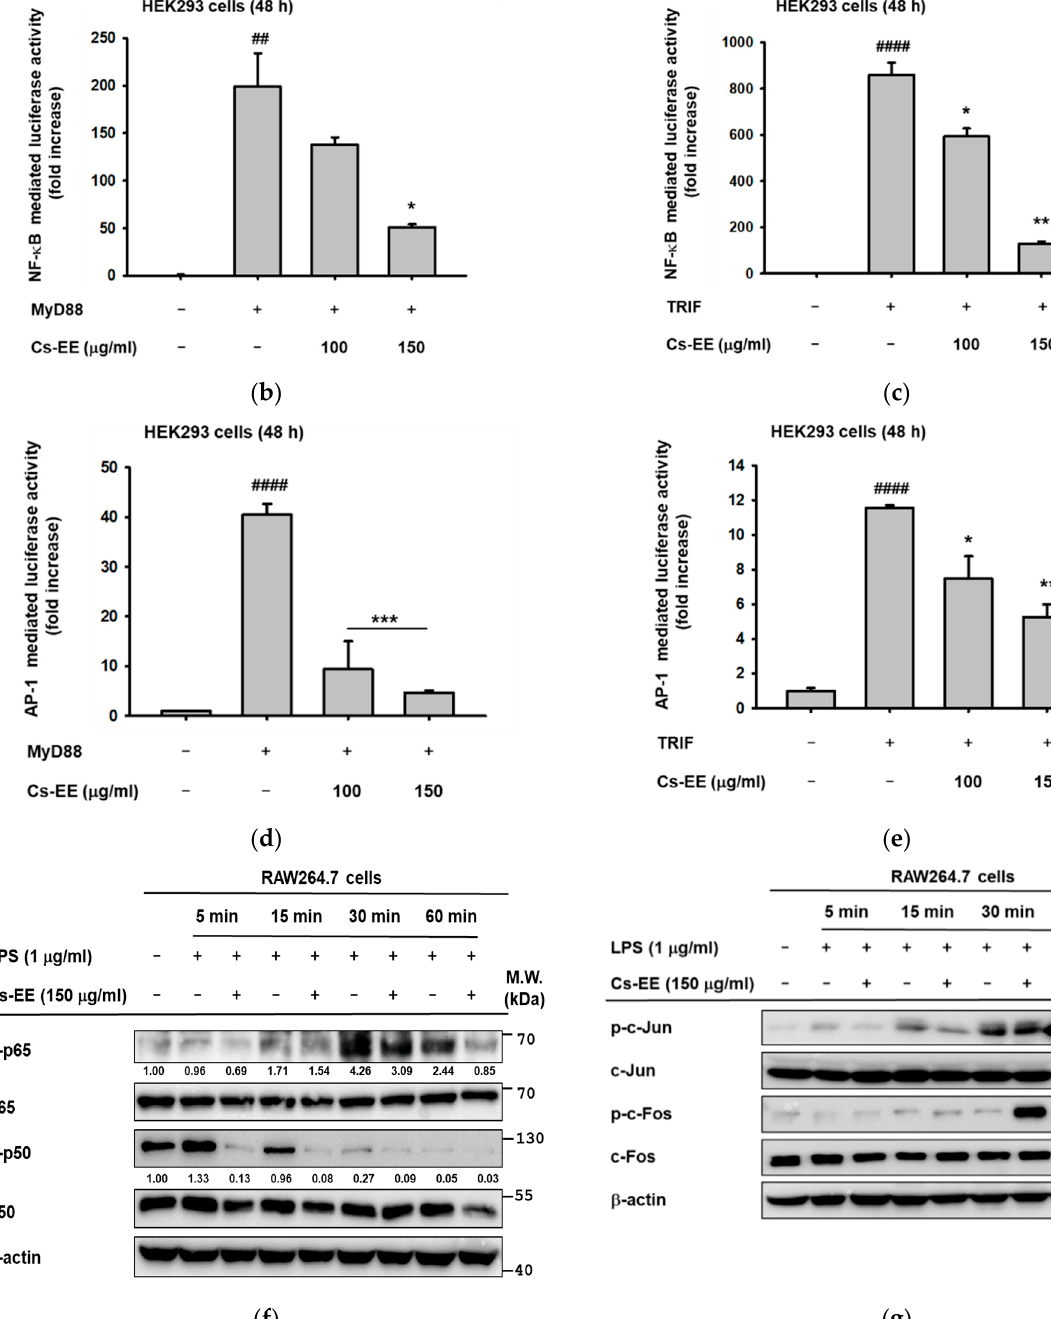
Figure 3. Effect of Cs-EE on the expression of inflammatory genes and transcriptional activation of NF- κ B and AP-1. ( a ) TNF- α , IL-6, and IL-1 β were analyzed by qPCR in LPS-treated RAW264.7 cells. ( b – e ) HEK293 cells were co-transfected with NF- κ B- or AP-1-Luc, as well as β -gal (0.8 μ g) together with MyD88 and TRIF for 48 h in the presence or absence of Cs-EE (100 and 150 μ g/mL) before being measured using a luminometer. ( f ) The phospho- and total forms of NF- κ B subunits, p50 and p65. The relative intensity values bellow the blot represent the quantification of band intensity which was measured by ImageJ and calculated as follows: (phospho-form of p65 or p50)/(p65 or p50). ( g ) The phospho- and total forms of AP-1 subunits, c-Jun and c-Fos, and β -actin from whole-cell lysates from LPS-treated RAW264.7 cells in the presence or absence of 150 μ g/mL of Cs-EE were determined by immunoblot analysis. Results (a–e) are expressed as mean ± SD. ## p < 0.01 and #### p < 0.0001 compared to normal group by the student’s t -test, and * p < 0.05, ** p < 0.01 and *** p < 0.001 compared to control group (inducer alone) by one-way ANOVA.